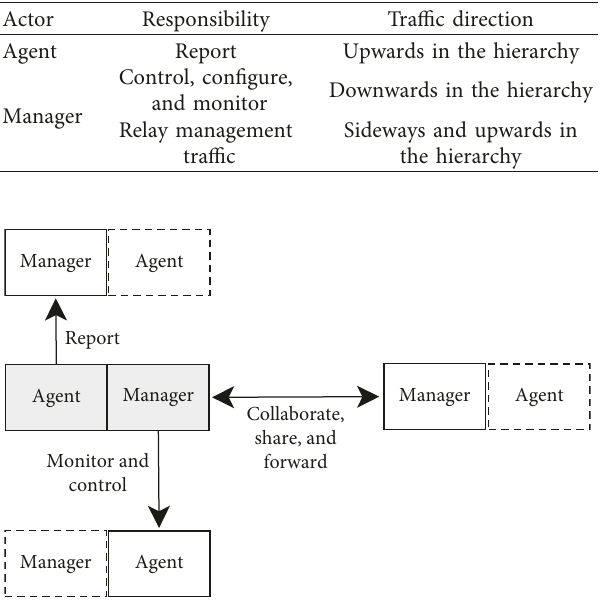
Figure 3: Responsibilities set by the management role (i.e., the actor type) and relative position in the hierarchy from the per- spective of the highlighted node (in the middle on the left).